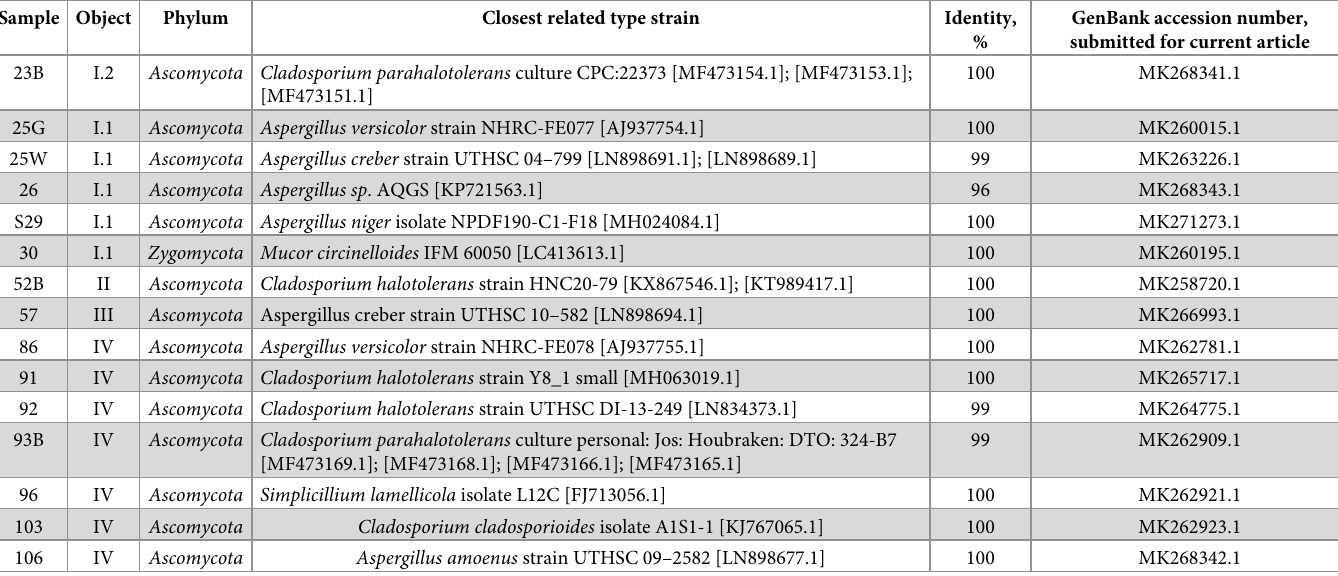
Table 1. Phylogenetic analysis of ITS1, 5.8S ribosomal RNA and ITS2 sequences from STG samples. Sample Object